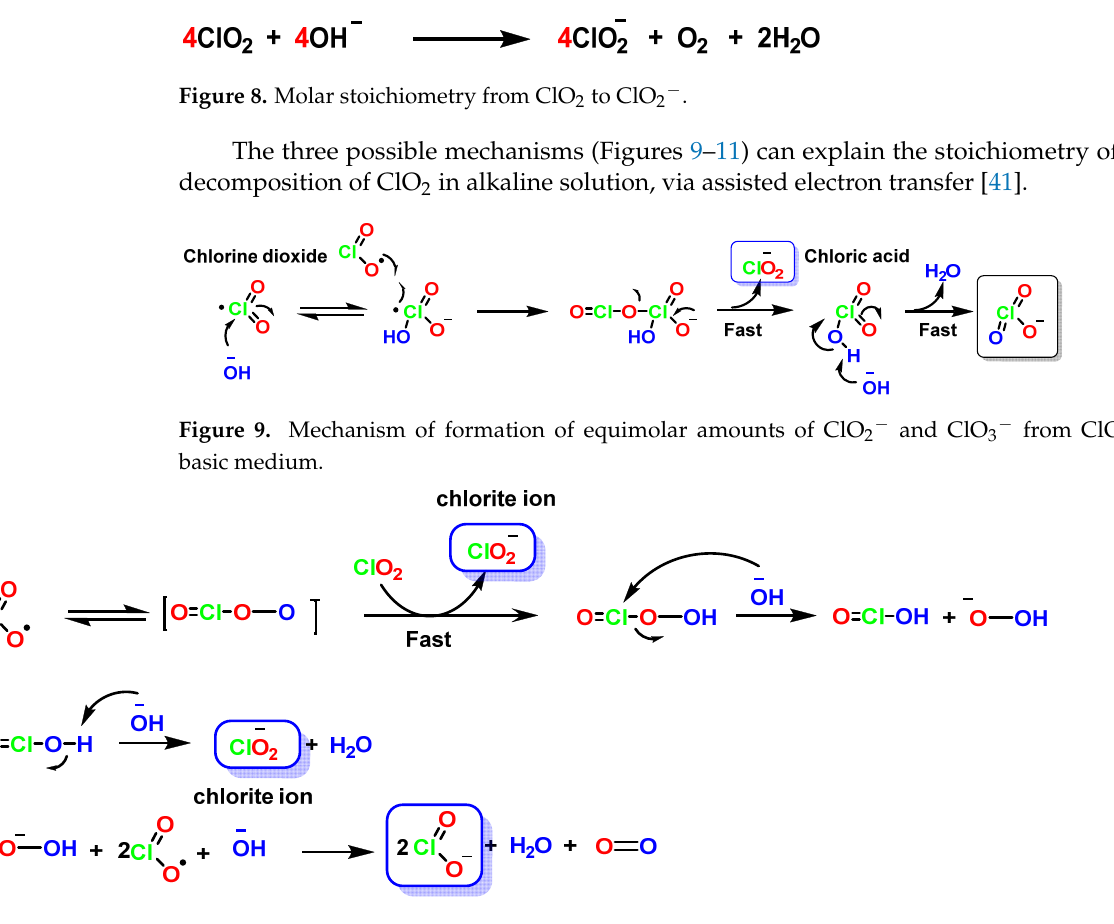
Figure 8. Molar stoichiometry from ClO 2 to ClO 2 − .